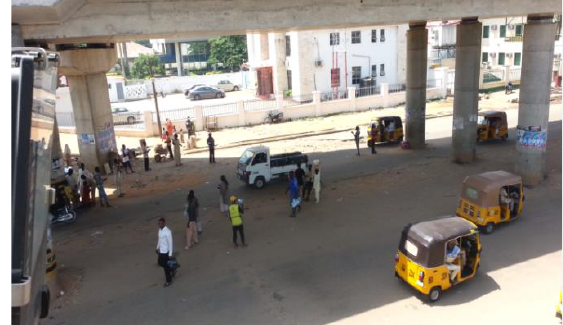
Figure 5: Street vendors on precarious location (at Airport road junction, Kano). They boarder banks and telecommunication companies, therefore, all mobile, carrying their merchandise. The high presence of police officers here leading to regular enforcement of the law. Hence, little investment in equipment on the vendor’s part. This particular stretch along the road does not lend itself to permanent vending activities. Source: Authors (2017).